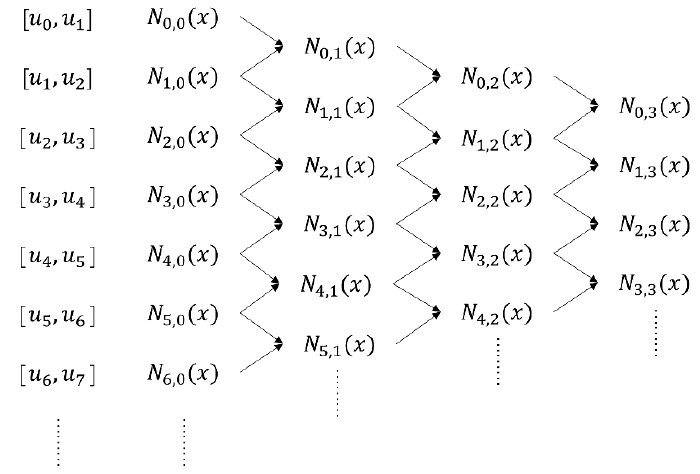
Figure 3. Operational relationship between the basic functions.